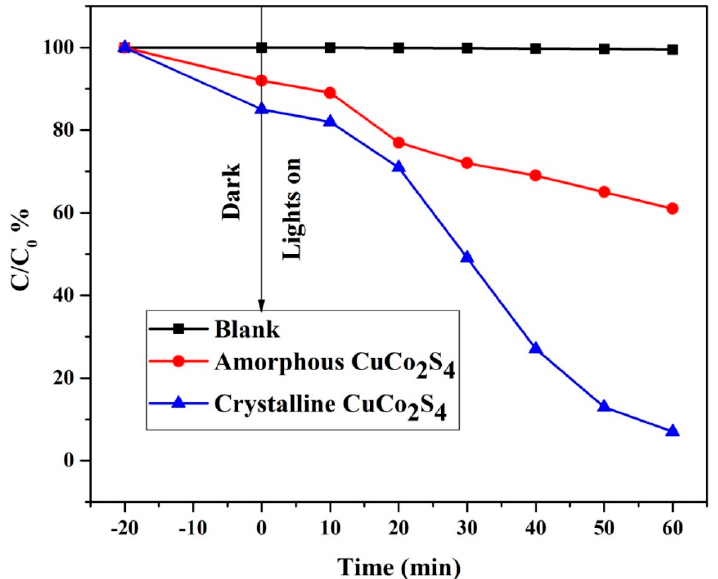
Figure 4. Photodegradation of MB with amorphous and crystalline CuCo 2 S 4 under visible-light irradiation.